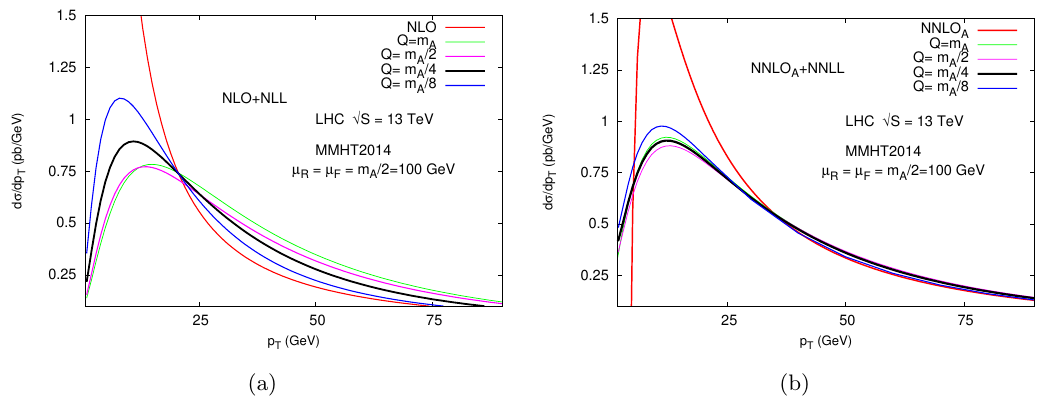
Figure 2 . Resummation scale variation for (a) NLO+NLL and (b) NNLO A +NNLL at 13 TeV. In (cid:12)gure 1 (14 TeV) and (cid:12)gure 2 (13 TeV) we study the e(cid:11)ect of resummation